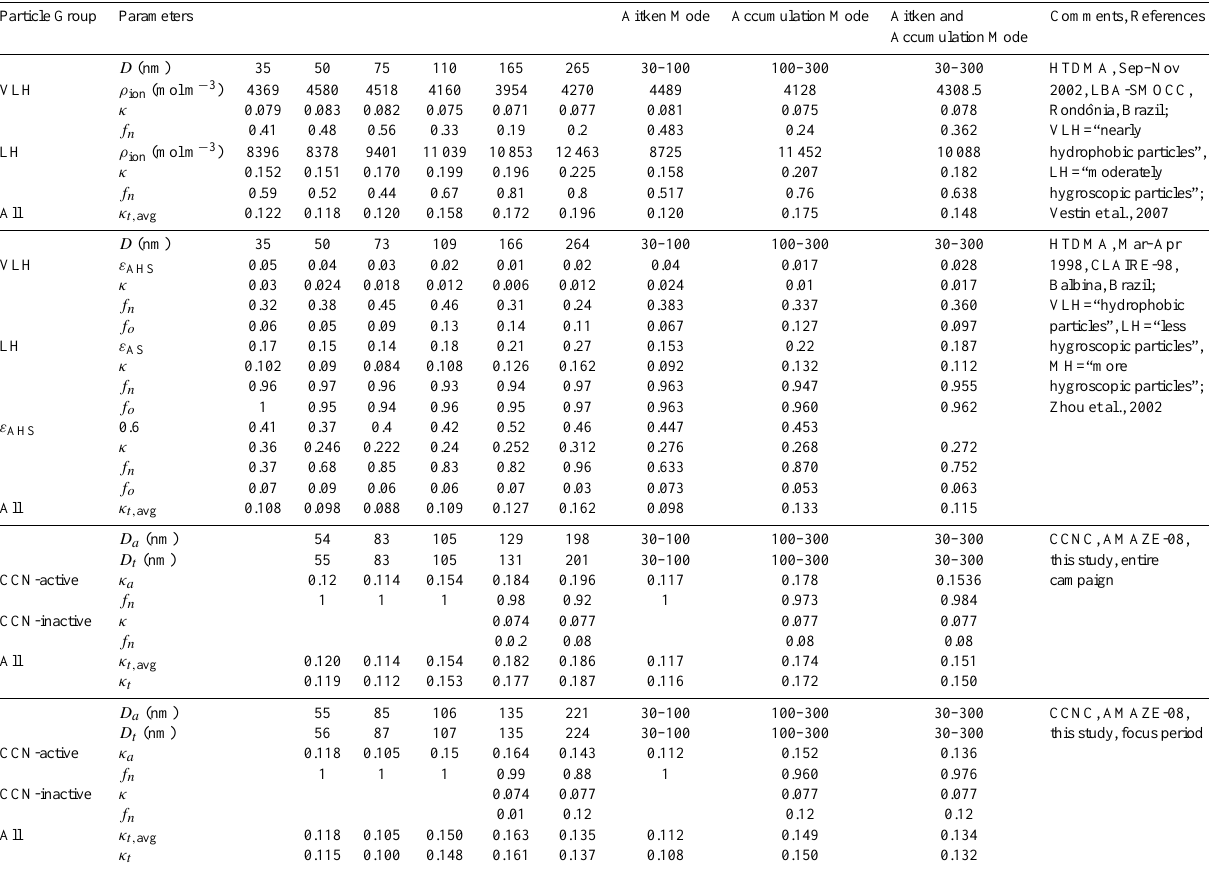
Table 2. Parameters characterizing the size-resolved hygroscopicity of aerosol particles in Amazonia during the wet season as observed in earlier studies (HTDMA measurements, campaign average values) and in the present study (CCNC measurements, campaign average and pristine focus period): soluble volume fractions referring to an equivalent of ammonium sulfate ( ε AS ) or ammonium hydrogen sulfate ( ε AHS ); equivalent molar densities of soluble molecules or ions ( ρ ion ); effective hygroscopicity parameters for specific groups and/or size ranges of aerosol particles ( κ , κ a ); effective hygroscopicity parameters characterizing the overall aerosol particle population as obtained by averaging over different externally mixed particle groups κ t, avg = 6 j ( κ j × f n,j × f o,j ) or by fitting of measured CCN efficiency spectra ( κ t , 2-parameter CDF fit); number fraction ( f n ) and relative frequency of occurrence ( f o ) of specific particle groups. The externally mixed particle